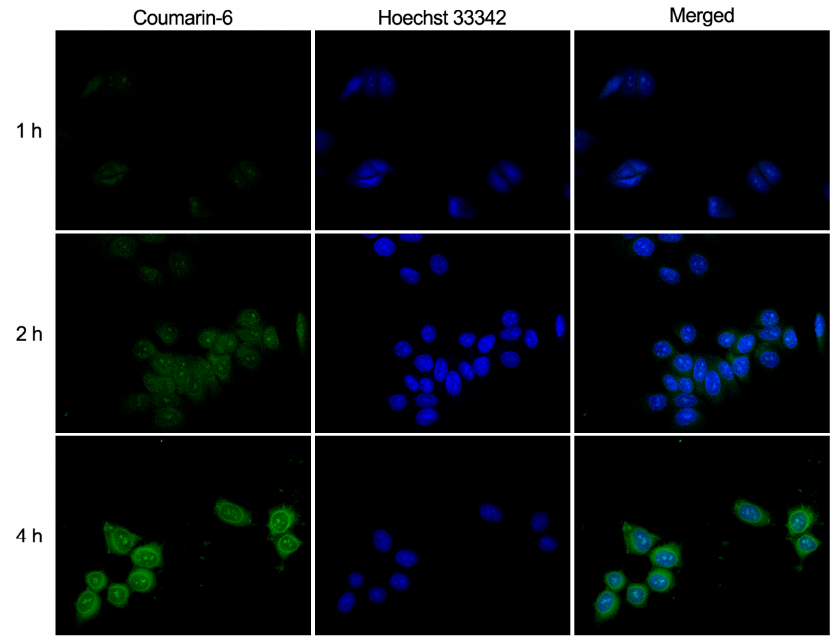
Figure 4. Confocal laser scanning microscopy images of MCF-7 cells incubated with micelles encapsulating coumarin-6 for 1, 2, and 4 h.